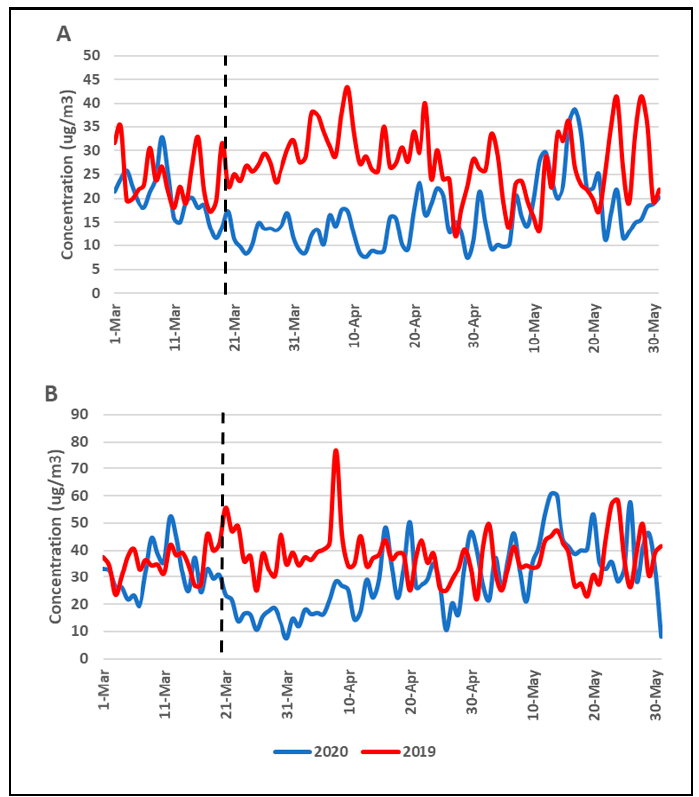
Figure 7. Average daily concentrations of PM 10 ( A ) and NO 2 ( B ) measured from March until May 2019 and 2020 in the air quality network of CABA. Black dotted line indicates the start of the pandemic lockdown (20 March 2020).